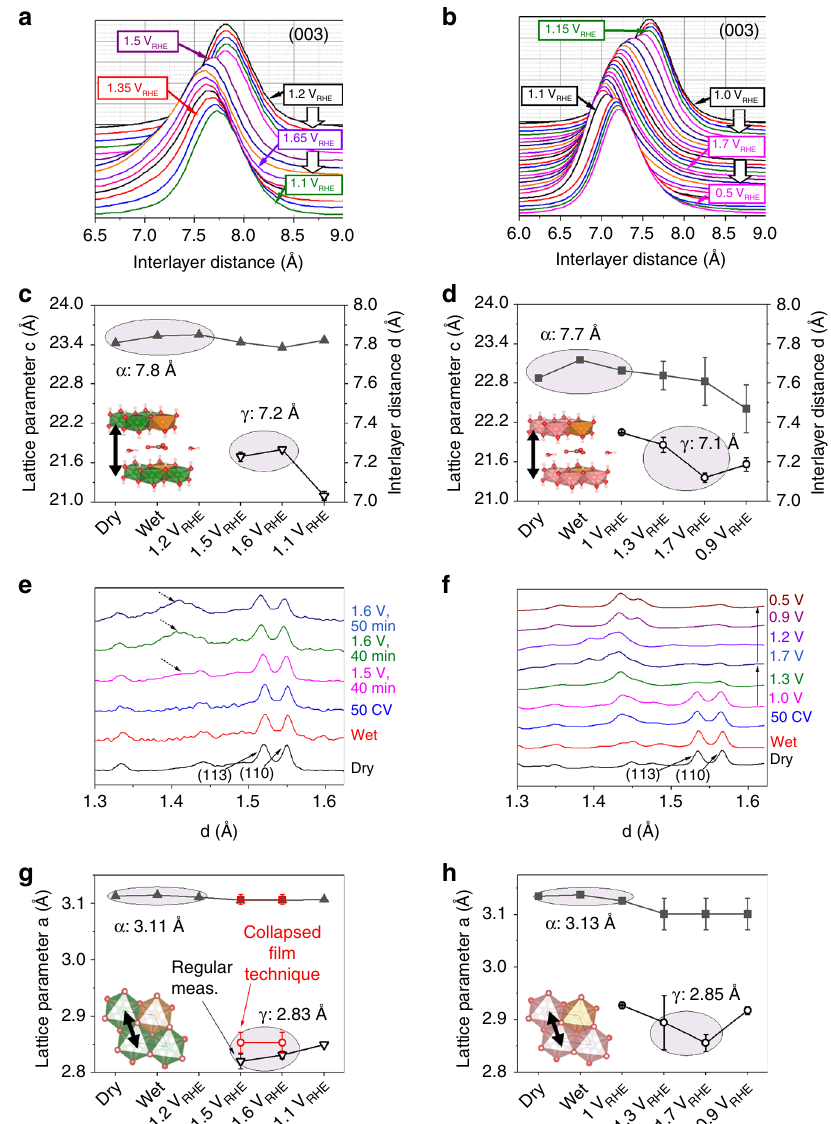
Fig. 2 The evolution of the interlayer spacing and the intralayer metal – metal distances of NiFe and CoFe LDHs from WAXS measurement. a , b Waterfall plot of normalized and background-subtracted (003) peak obtained during in-situ WAXS in 0.1 M KOH and potential steps for NiFe LDH ( a ) and CoFe LDH ( b ). c , d Interlayer distances for NiFe LDH ( c ) and CoFe LDH ( d ) obtained by Rietveld re fi nement. Full and open symbols are used for different phases. The error bars represent the SE provided by Topas. e , f In-situ WAXS patterns for d -values close to the (110) peak of NiFe LDH ( e ) and CoFe LDH ( f ) under various conditions. For NiFe LDH, the WAXS patterns at the reported potentials have been obtained by the collapsed fi lm technique. In e , the dashed arrows point to the feature associated to the γ -phase. g , h Lattice parameter a, corresponding to the intralayer metal – metal distance in NiFe LDH ( g ) and CoFe LDH ( h ) obtained by Rietveld re fi nement. Full and open symbols are used for different phases. Error bars represent SD provided by Topas for the re fi ned